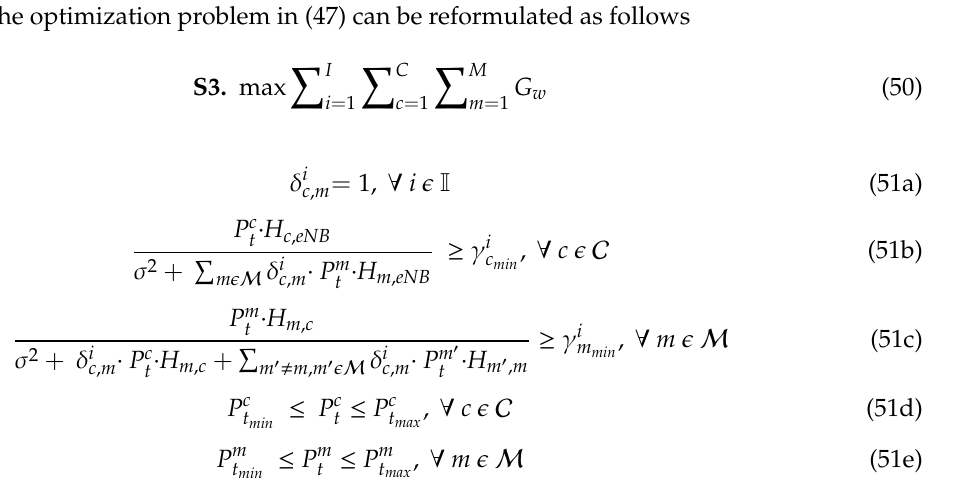
Algorithm 3 : Pseudo Code for the Auction-based Matching Algorithm